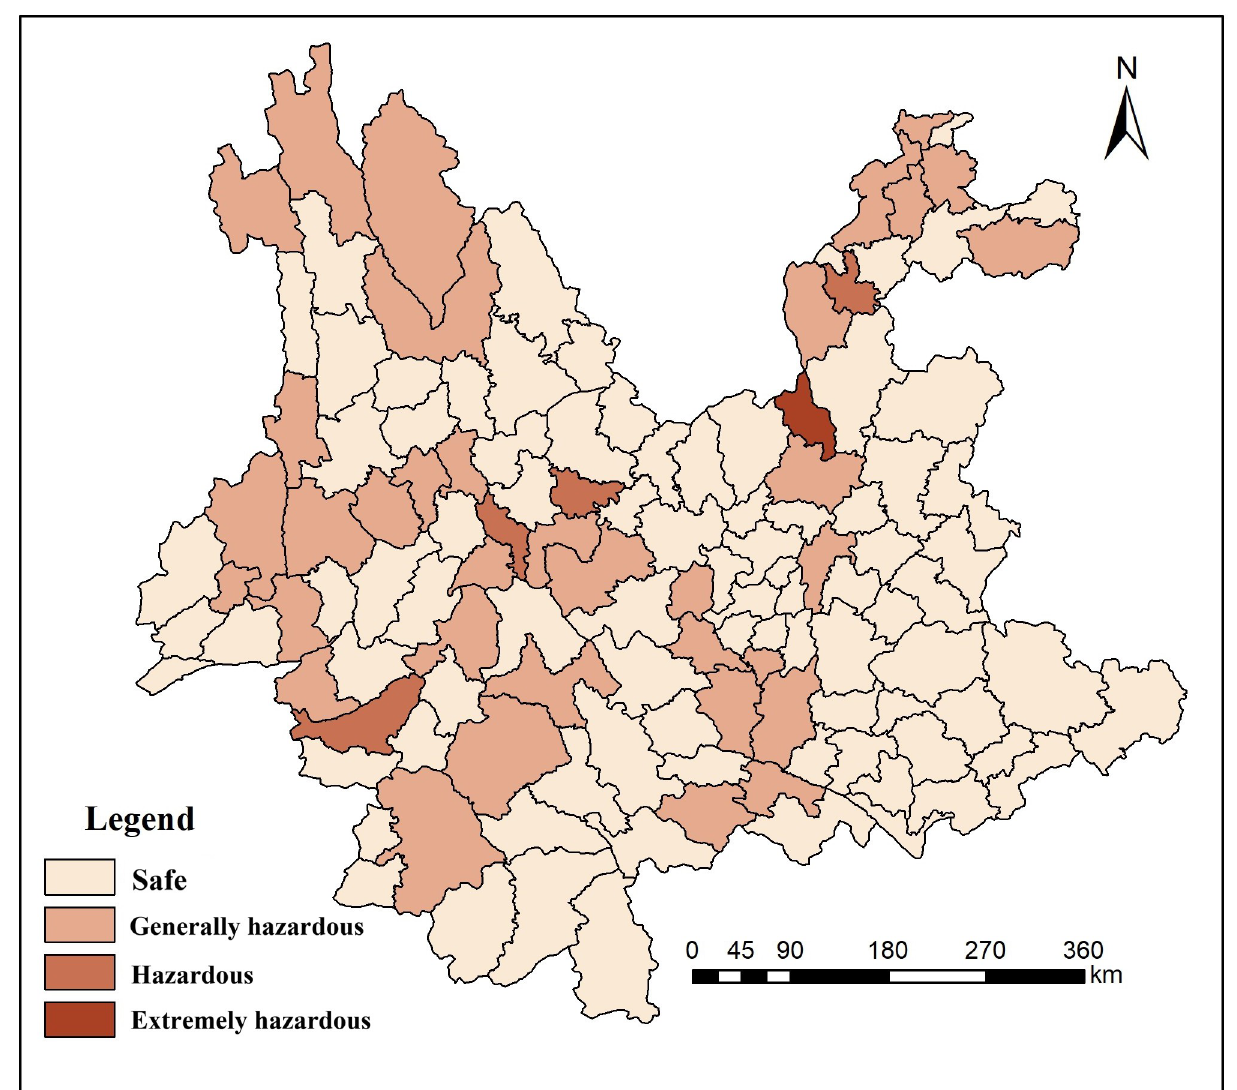
Fig 6. Risk assessment of geological disasters in Yunnan